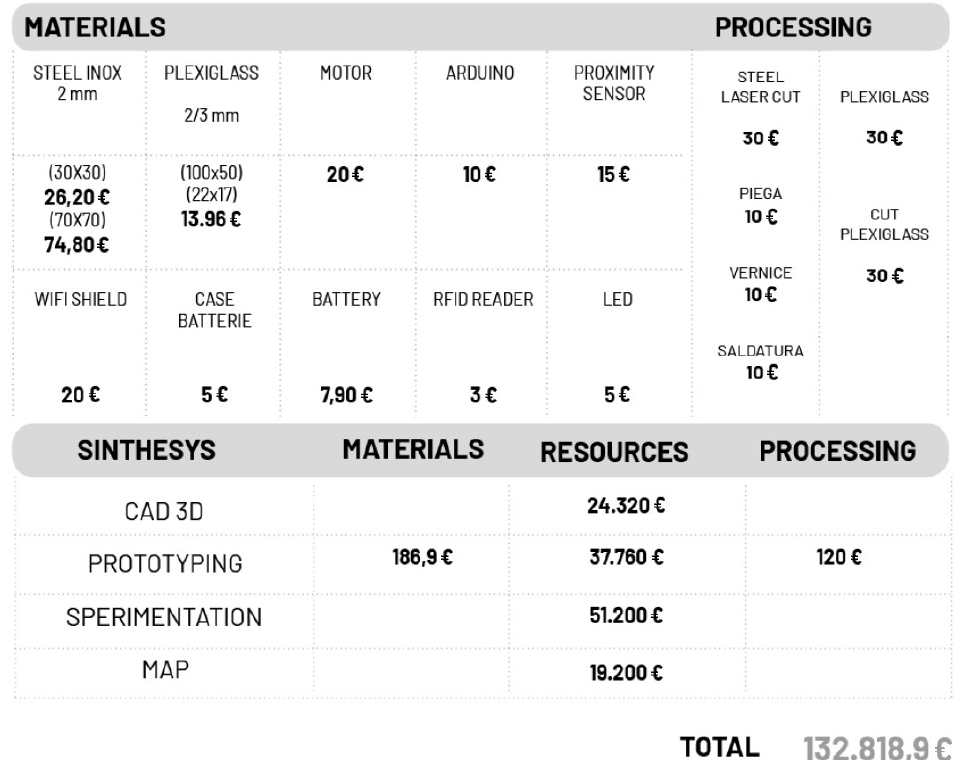
Figure 17. Budget—Resources & Materials.